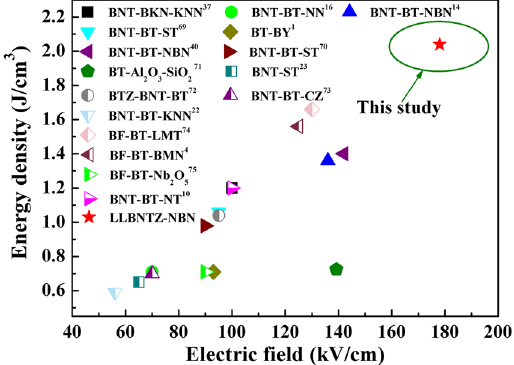
Figure 9. Comparison of W 1 and BDS between (1-x)LLBNTZ-xNBN ceramics and other lead-free ceramics. (BNT: Bi